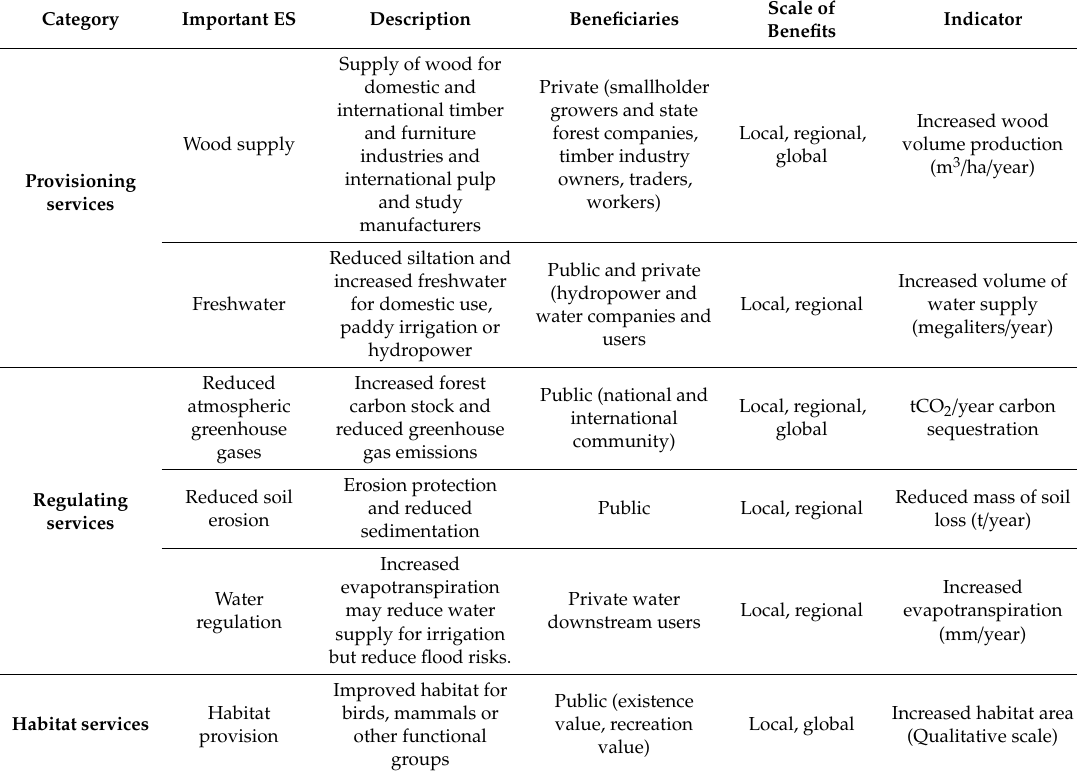
Table 2. Important forest ecosystem services (ES) from planted forests identified in Th ừ a Thi ê n-Hu ế and Qu ả ng Tr ị